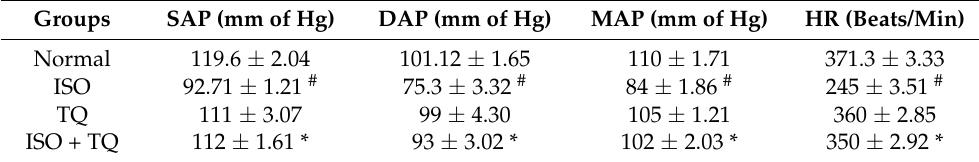
Table 1. The effect of TQ on a hemodynamic parameter in ISO-induced myocardial infraction.